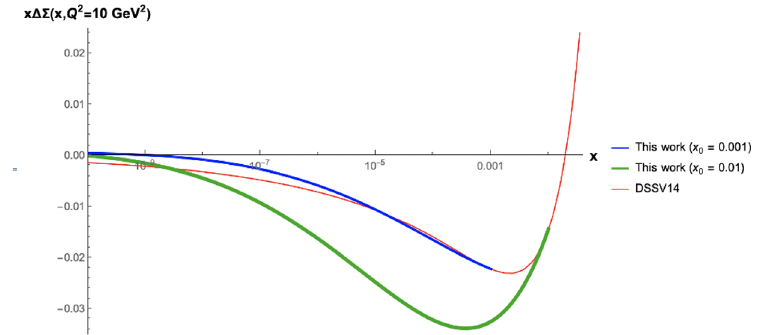
Figure 5 . Plots of x (cid:1)(cid:6)( x; Q 2 = 10 GeV 2 ) versus x . The thin (red) line depicts the results from DSSV14 [6], while the thick (green) and medium-thick (blue) lines show the results of matching our asymptotics (5.1) to DSSV14 at x 0 = 0 : 01 and x 0 = 0 : 001, respectively.